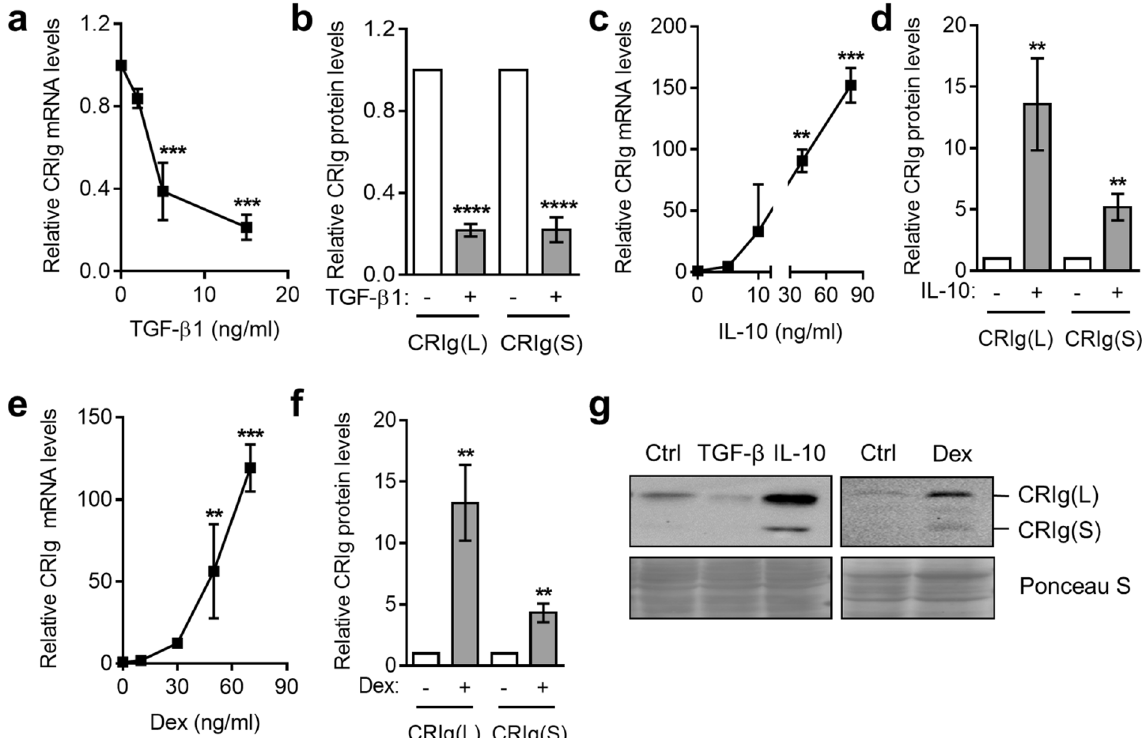
Figure 4. The effect of regulatory cytokines TGF- β 1 and IL-10 on CRIg + macrophage development. Monocytes were cultured in the presence of 0, 2, 5, 15 ng/ml TGF- β 1 ( a ) or 0, 5, 10, 40, 80 ng/ml IL-10 ( c ) and CRIg mRNA expression was measured by qPCR. For CRIg protein expression monocytes were treated with 15 ng/ ml TGF- β 1 ( b ) or 40 ng/ml IL-10 ( d ). ( e ) Monocytes were cultured in the presence of dexamethasone and the CRIg mRNA determined. ( f ) For protein expression monocytes were treated with 30 ng/ml dexamethasone. ( g ) Representative blots are shown (dexamethasone treatment was analysed on a separate blot from TGF- β 1 and IL-10). Data are presented as means ± SD of three experiments, each conducted with cells from different individuals. ** p < 0.01, *** p < 0.001, **** p <